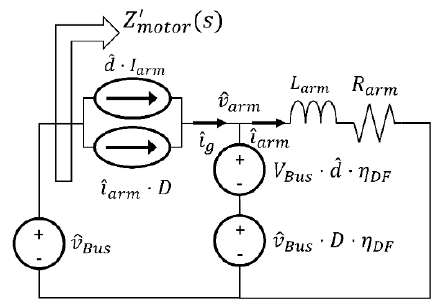
Figure 17. The small-signal model of the motor drive-electric motor-vehicle system.